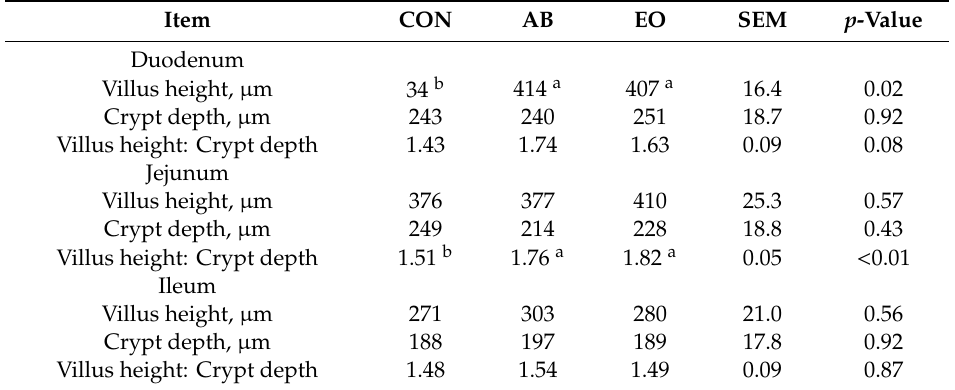
Table 5. E ff ects of essential oil supplementation on small intestine morphology of weaned piglets 1 .